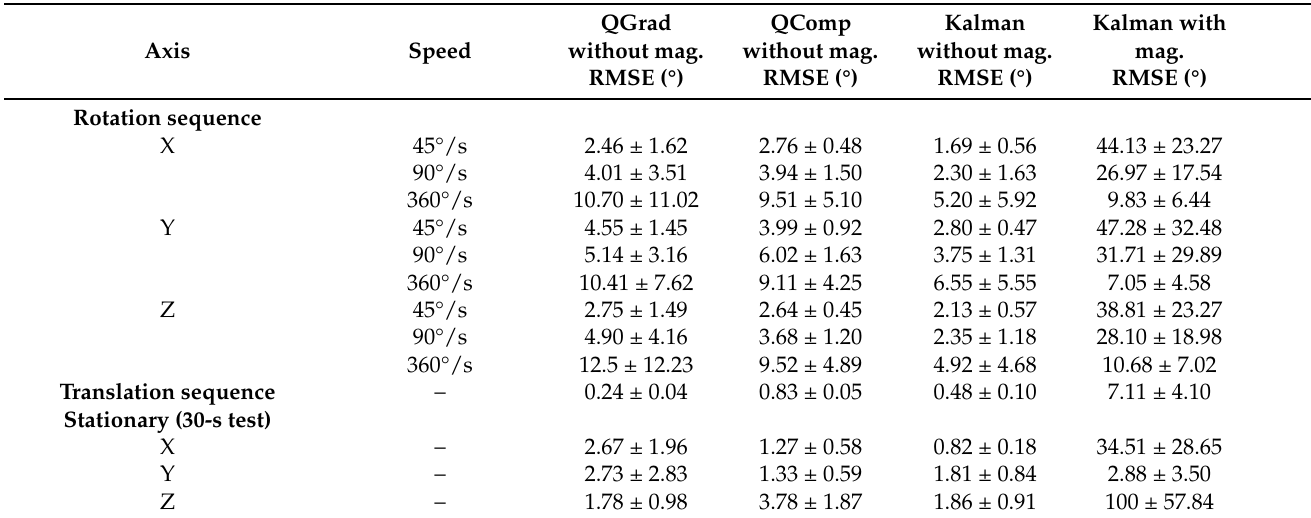
Table 3. RMSE of the angular difference between measured and reference values for each IMU data fusion method during rotation, translation, and stationary sequences. Axis refers to the IMU axis of rotation for the rotation sequence and the IMU axis aligned with gravity for the stationary trial.